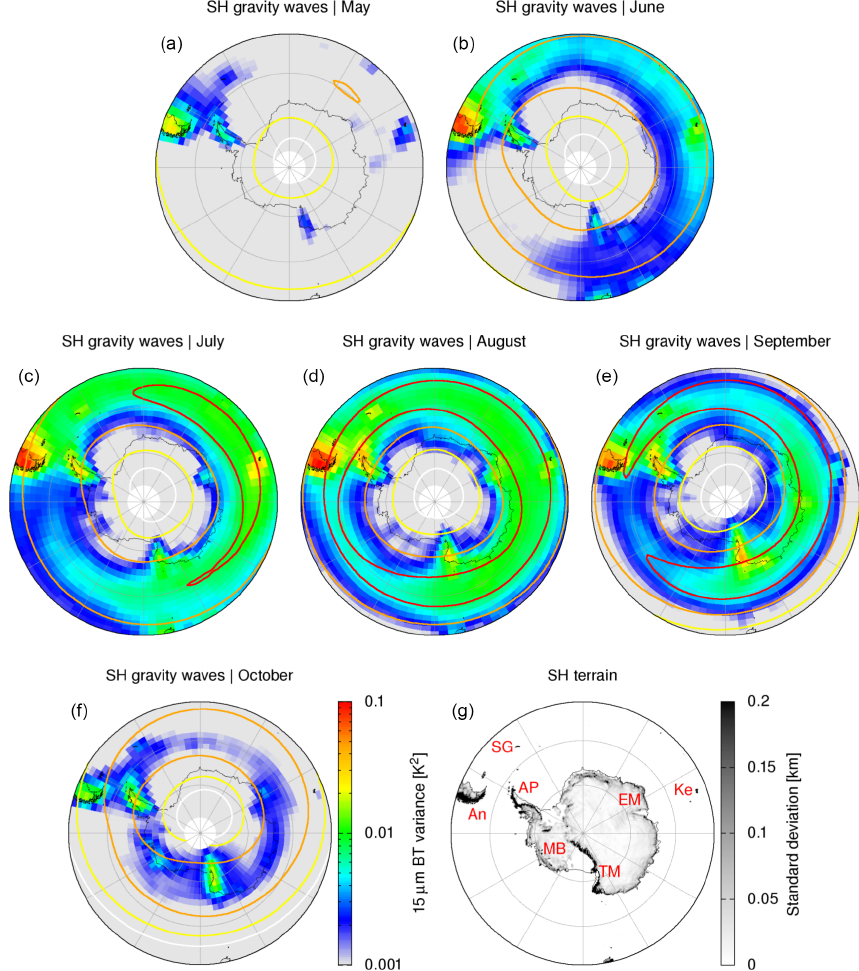
Figure 8. Same as Fig. 7, but for the Southern Hemisphere and the months of May to October. The red labels in the terrain map indicate the locations of Marie Byrd Land (MB), the Andes (An), the Antarctic Peninsula (AP), South Georgia (SG), Enderby Land and Mac. Robertson Land (EM), the Kerguelen Islands (Ke), and the Transantarctic Mountains